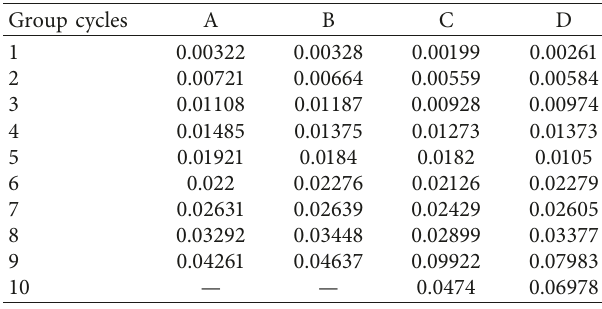
Table 1: Hysteresis energy in every cycle (MJ/m 3 ).